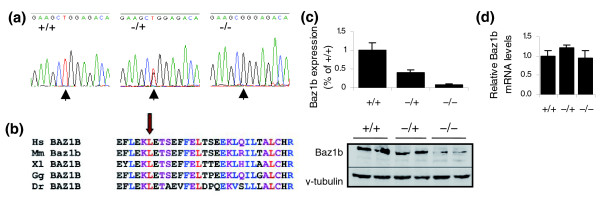
A point mutation in Baz1b correlates with the MommeD10-/- phenotype. (a) A single base-pair mutation was detected in exon 7 of Baz1b. Representative chromatograms from one wild type, one heterozygote and one homozygote are shown. This results in a non-conservative amino acid change, L733R. (b) The MommeD10 point mutation (arrow) modifies an amino acid highly conserved across species (Hs, Homo sapiens; Mm, Mus musculus; Xl, Xenopus laevis; Gg, Gallus gallus; Dr, Danio rerio). (c) Whole-cell lysates from four 14.5 dpc heads of each genotype were probed with anti-Baz1b. Anti-γ-tubulin was used as a loading control. Quantification of Baz1b relative to γ-tubulin shows negligible levels of Baz1b in MommeD10-/- mice. A representative western blot is shown. (d) Expression analysis by quantitative real-time RT-PCR was performed on mRNA prepared from 14.5 dpc heads. Levels of Baz1b mRNA were not affected by the mutation. Analysis was performed on three individuals of each genotype and normalized to two house-keeping genes. Error bars in all graphs represent SEM.